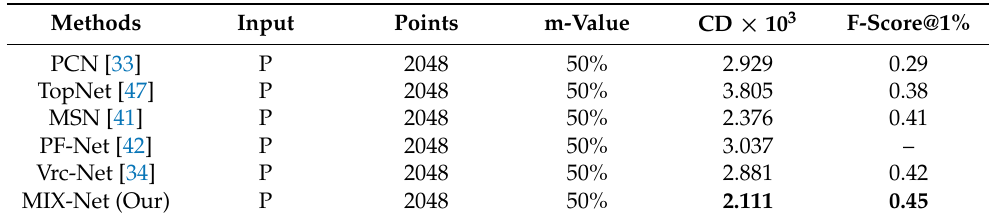
Table 8. Point cloud completion results (CD and F-Score@1%) on the ShapeNet-Part dataset (2048